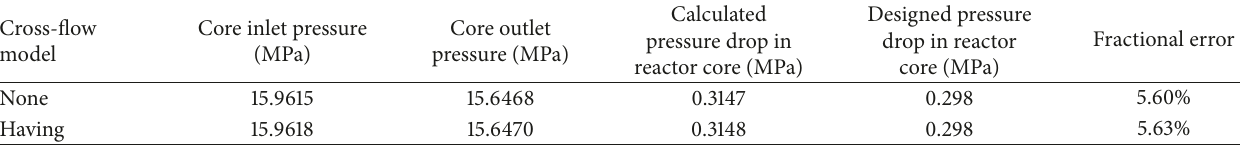
Table 18: The influence of cross-flow model on the pressure drop in the reactor core.